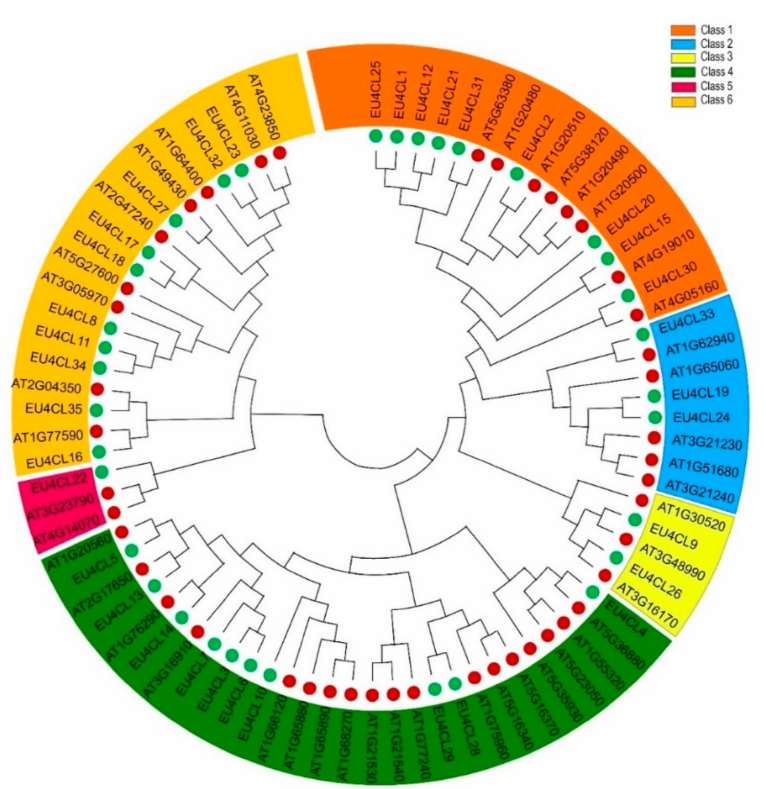
Figure 2. Unrooted phylogenetic tree representing relationships among 4CL domains of E. ulmoides and Arabidopsis